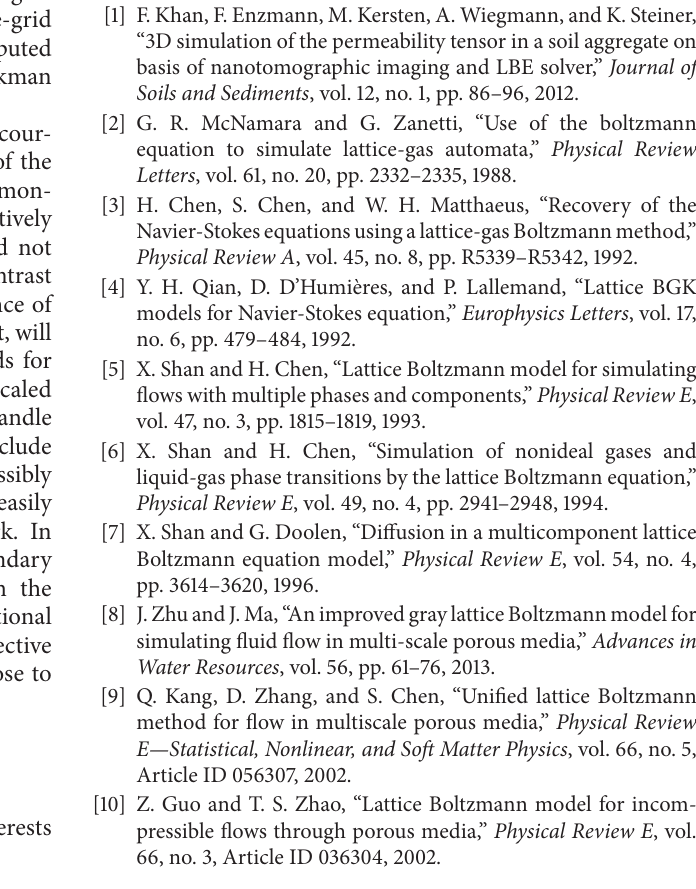
Figure9:Detailedcomparisonsof 𝑝 , 𝑢 ,and V betweenthefine-gridaveragedresultsandcoarse-gridresultsusing 𝜅 ∗ (𝜅, ] eff ) , ] eff = 10 −5 m 2 s −1